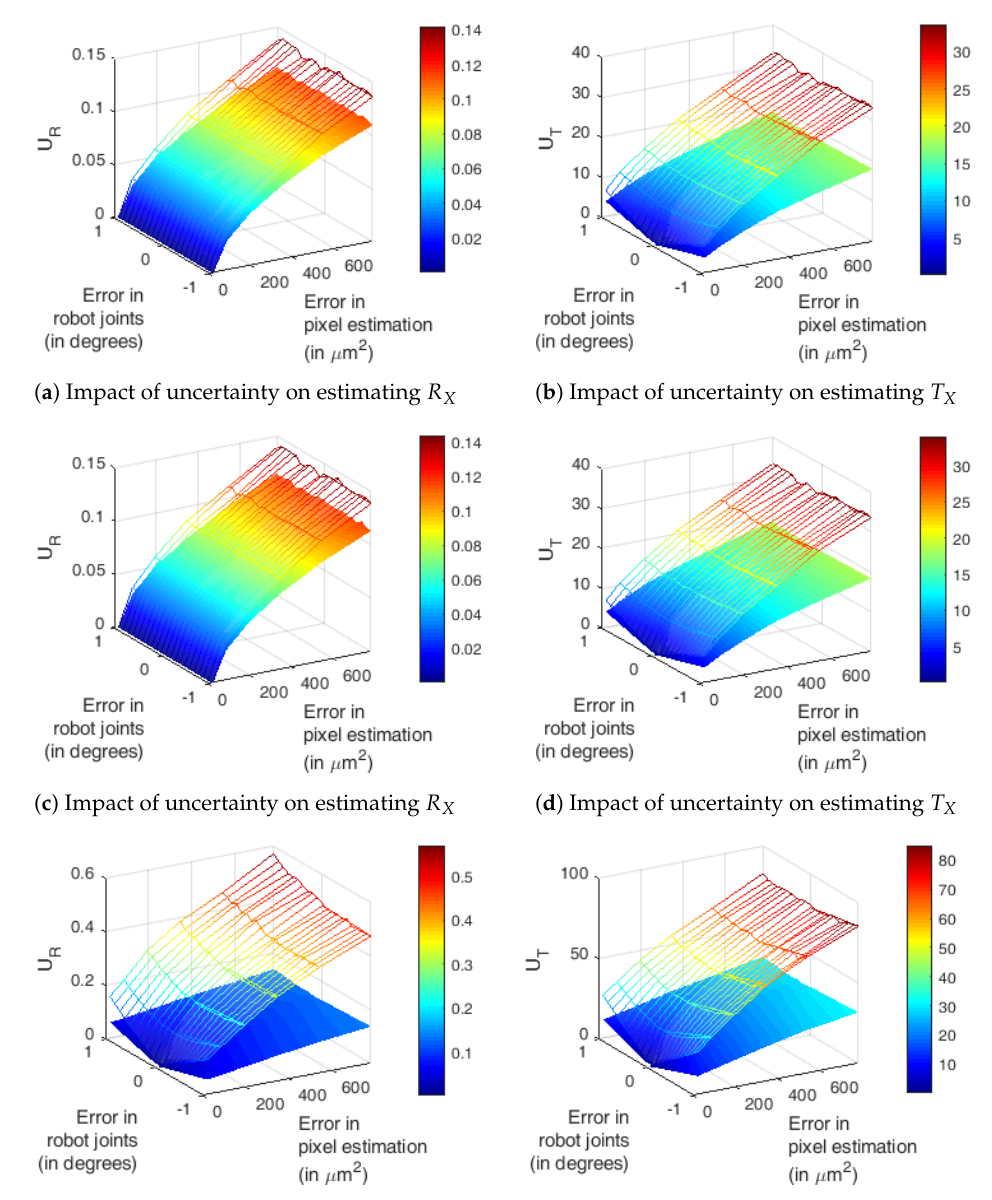
Figure 4. Error norms associated with rotation matrix and translation vector estimated using: ( a , b ) Horaud–Dornaika method; ( c , d ) Tsai–Lenz method; ( e , f ) Andreff et al. method. The mesh plot represents error values for η = 4, while solid surface plot represents error values for η =